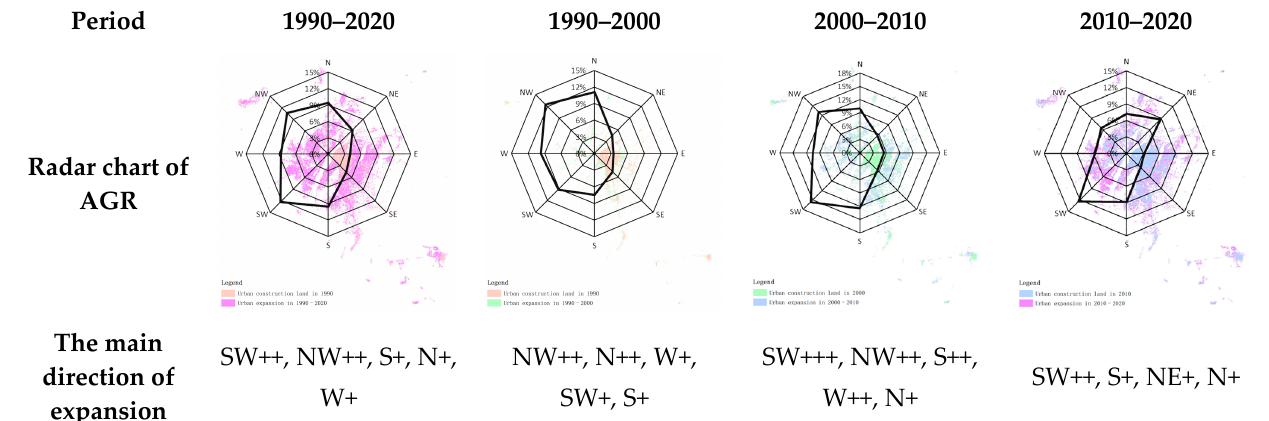
Figure 7. Eight-direction radar chart of construction land expansion in Nanchang from 1990 to 2020. +++, ++, + represent the expansion speeds from high to low,